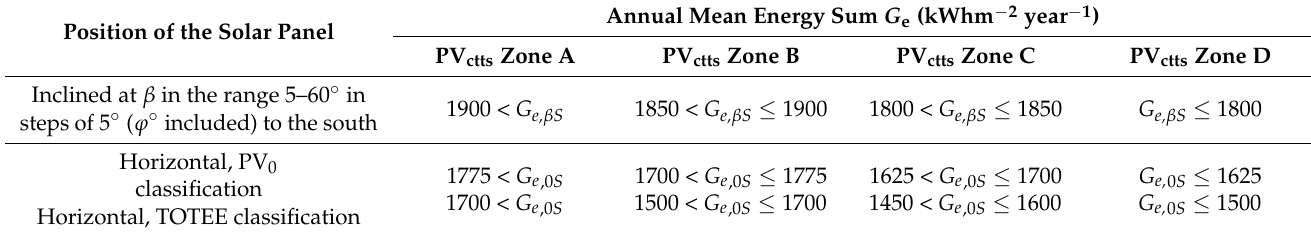
Table 4. Range of the annual mean solar energy sums G e, β S received by planes of various tilt angles β , averaged across the 33 locations to define the 4 PV ccts zones in Greece for solar availability under all-sky conditions. The range of the annual mean solar energy sums received on a horizontal plane G e ,0 S is also given for reference. One should notice the different ranges of the four bands in the case of the received energy on a horizontal plane in the PV 0 and TOTEE classifications. Position of the Solar